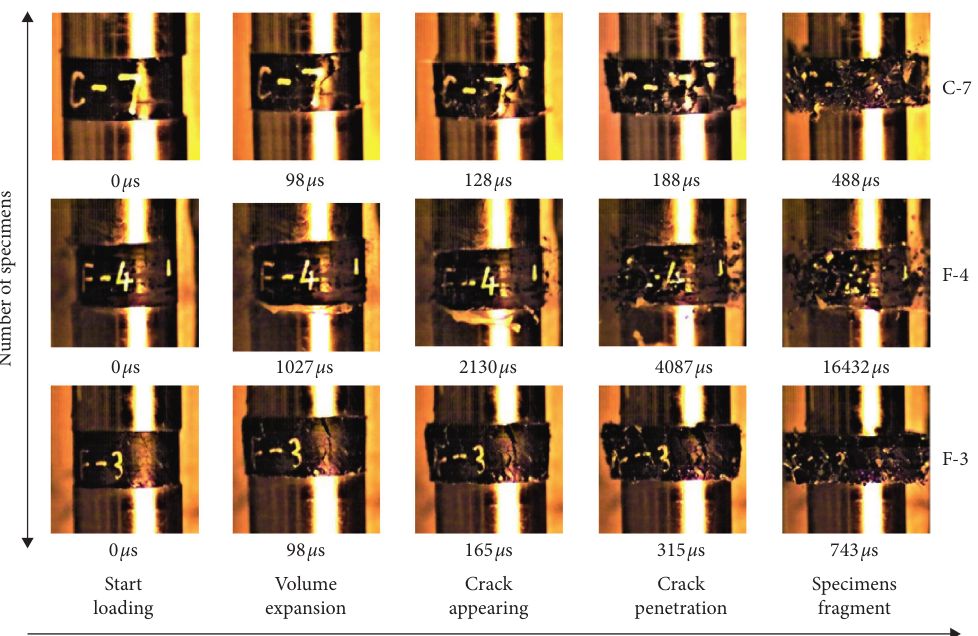
Figure 9: Typical dynamic compression crack initiation and propagation characteristics.